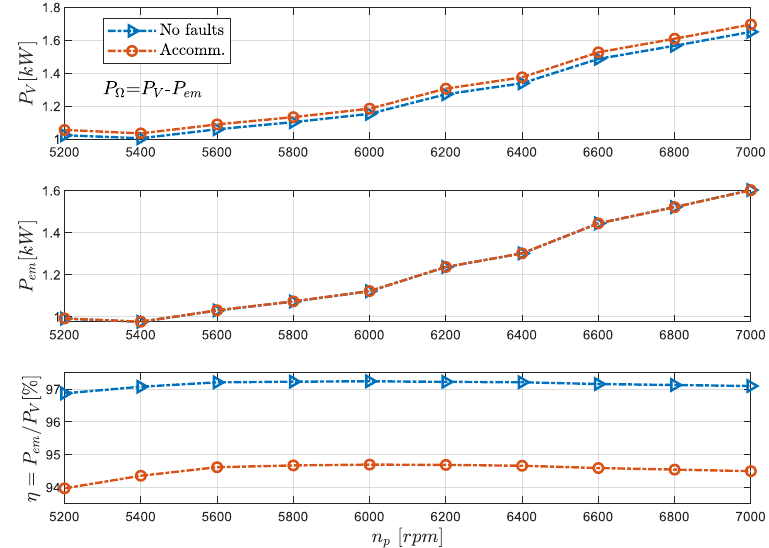
Figure 19. Steady-state power performances at different propeller angular speeds (comparison between healthy and accommodated system with phase a open).